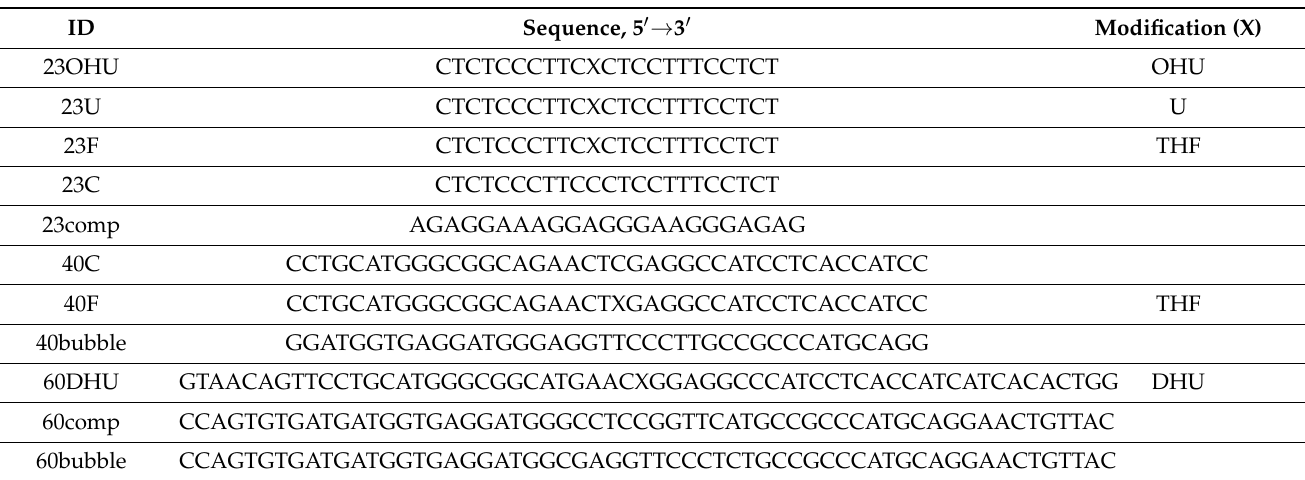
Table 1. Oligonucleotides used in this